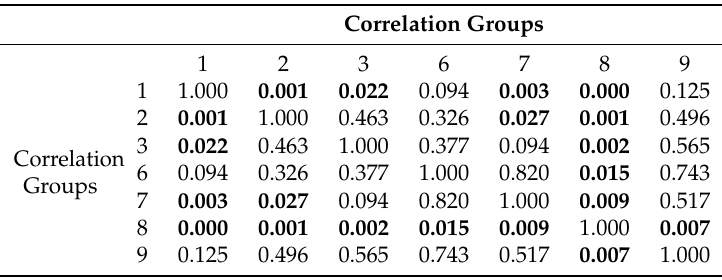
Table 6. p -values between the mean results of variable V 4 “collagen diameter” obtained from the spectra of the corresponding correlation